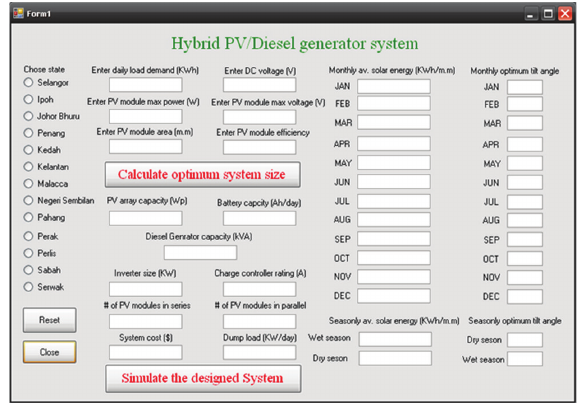
Figure 4: Interface for designing optimal hybrid PV/diesel genera- tor system.